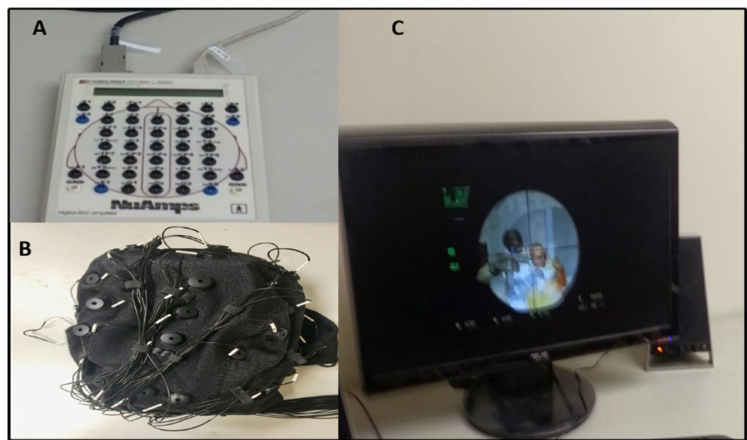
Figure 2. The electroencephalography (EEG) devices used in battleground scenario. ( A ) Neuro Scan NuAmps signal amplifier. ( B ) EEG cap with 32-channels. ( C ) Experimental screen in battleground scenario.